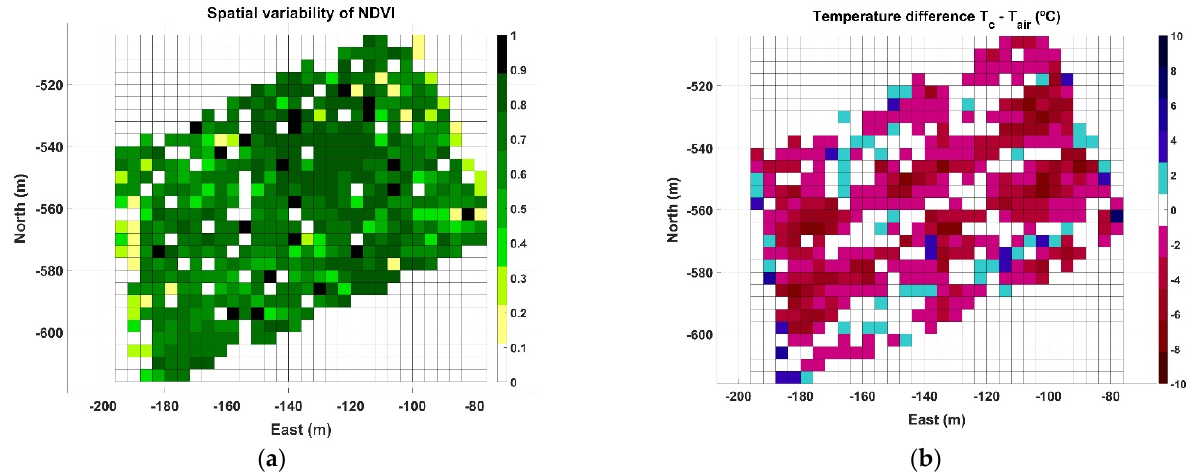
Figure 12. Grid maps for Map B: ( a ) spatial distribution of NDVI; and ( b ) ∆ T (°C).